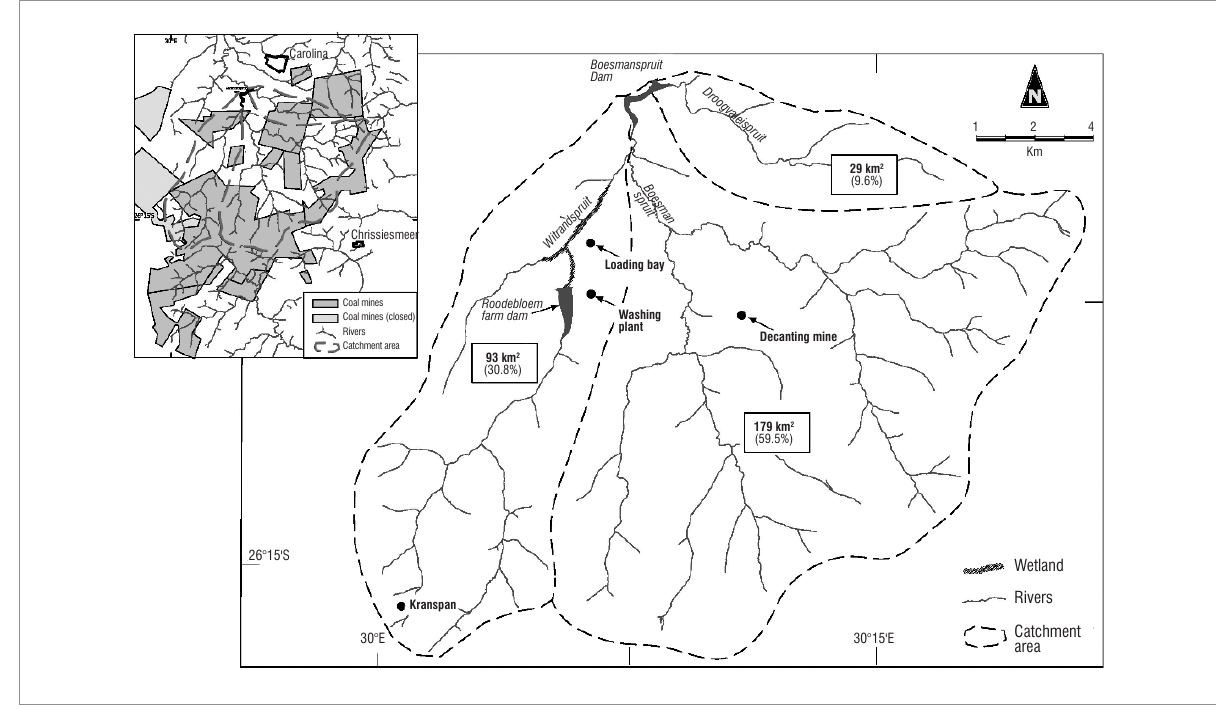
Figure 3: The catchment of the Boesmanspruit Dam. The inset shows coal mine lease areas in the region.